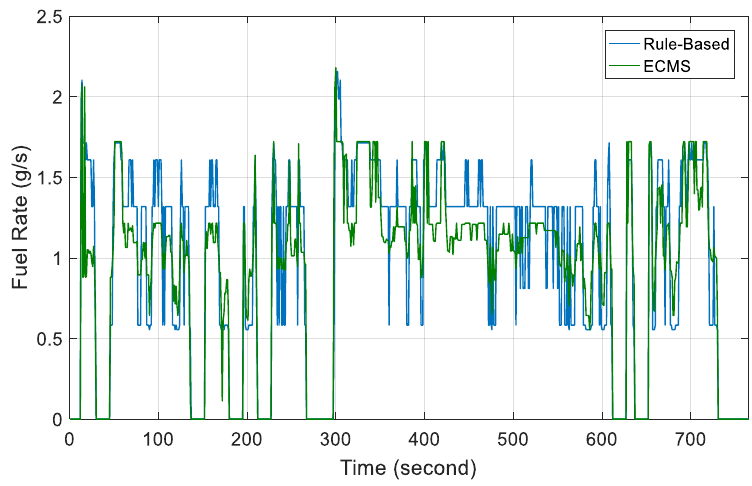
Figure 14. Comparison of fuel consumption rate of highway cycle.